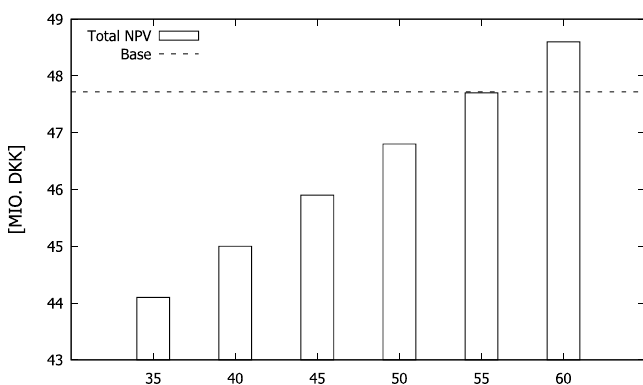
Fig. 13 Subsidy effect on the total NPV of the BESS